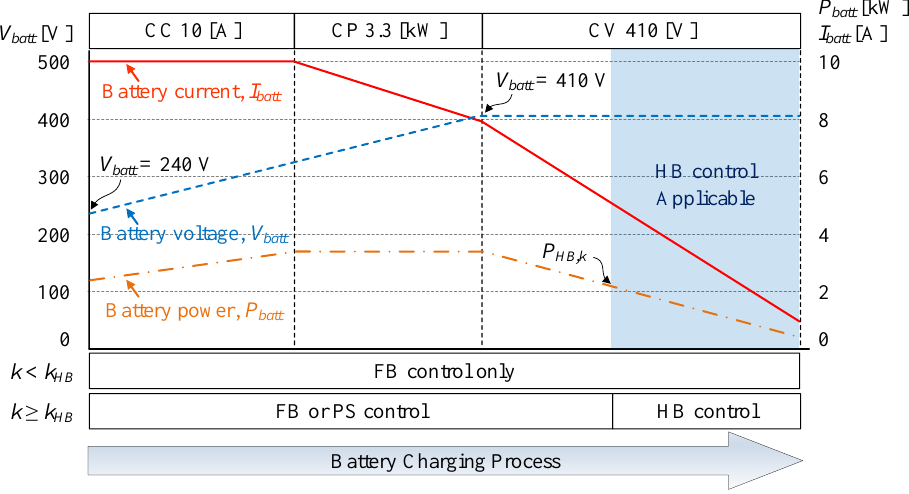
Figure 5. Charging profile of an EV battery pack and control modes.